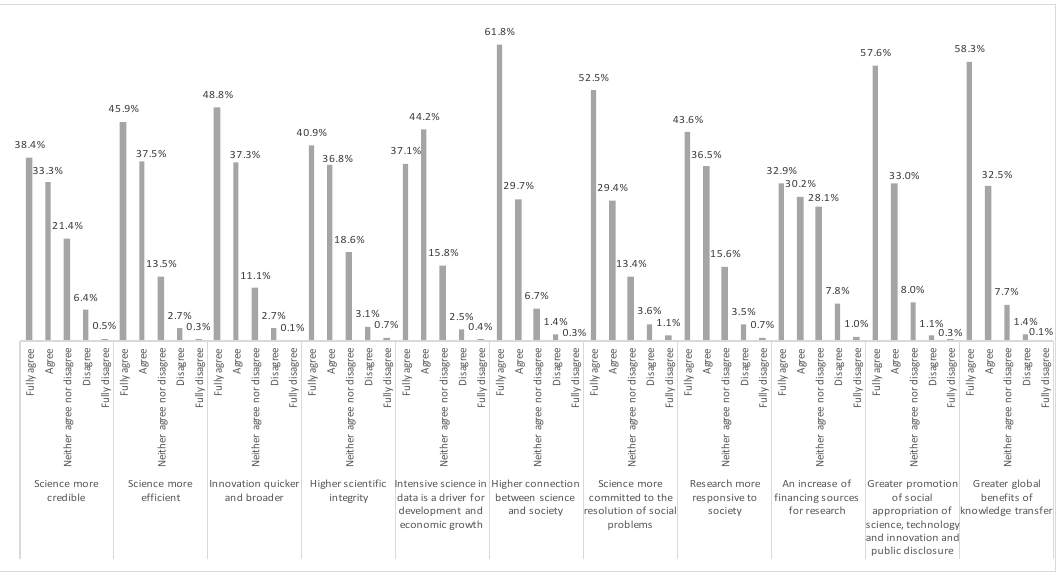
Figure A2. The main barriers to open science, according to Colombian researchers.